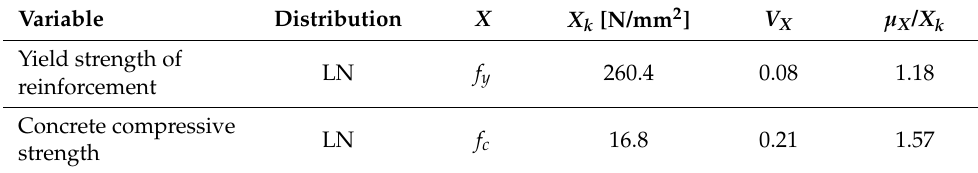
Table 9. Second stage updated probabilistic models.